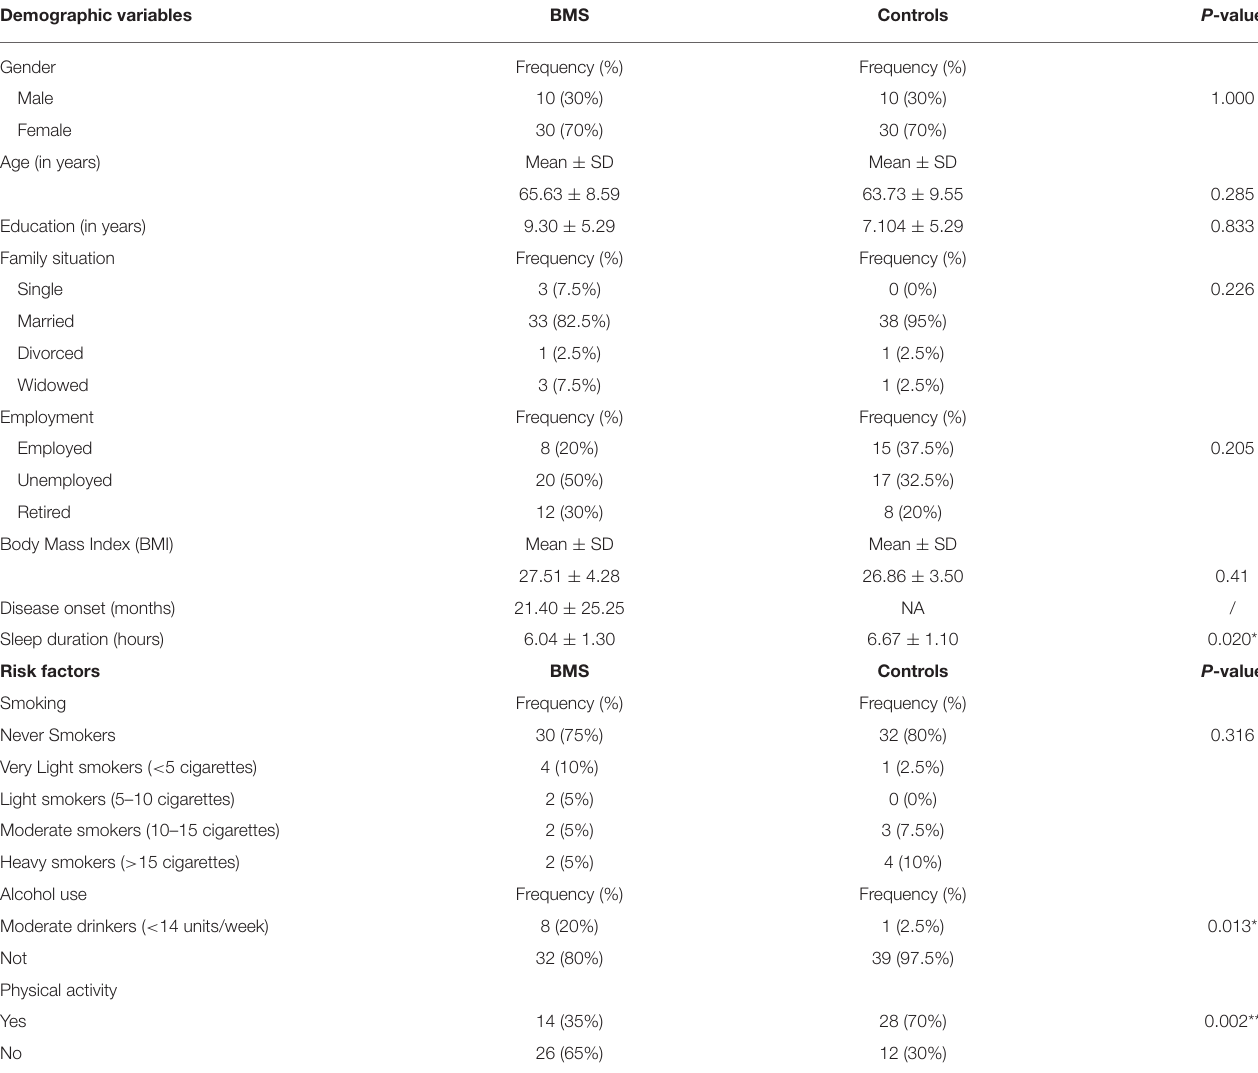
TABLE 1 | Sociodemographic characteristics, body mass index (BMI), disease onset, sleep duration, and habits in patients with burning mouth syndrome (BMS) and control subjects. Demographic